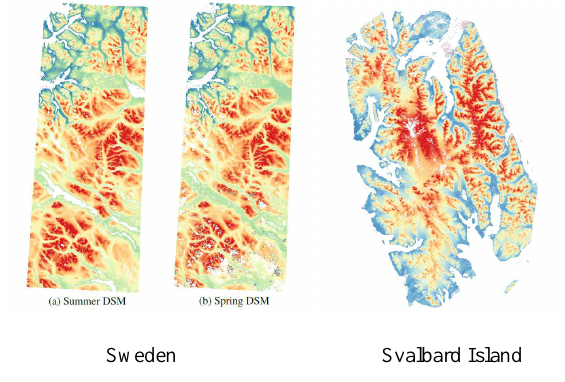
Figure 22. DSM generated over the test areas in Sweden (2 left) and Svalbard Island (right). Values range from 0m (blue) to 1500m (left red) and 1000m (right red). DSM Resolution is 10